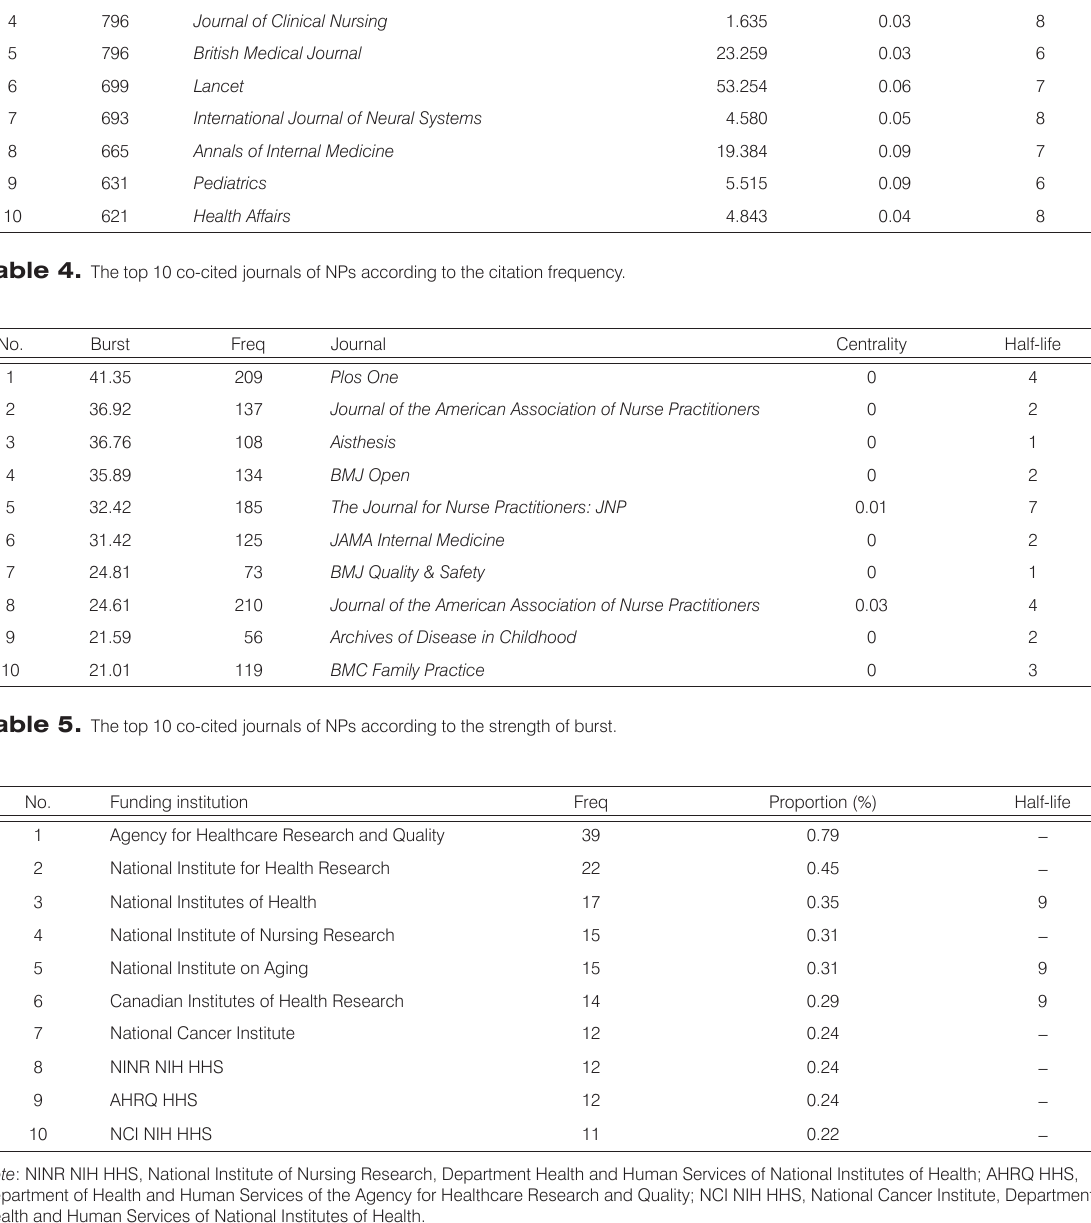
Table 6. The top 10 funding institutions according to